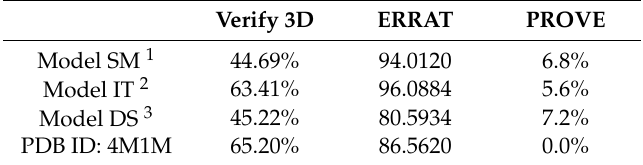
Table 8. Verify 3D, ERRAT and PROVE Scores of the models selected from each modeling